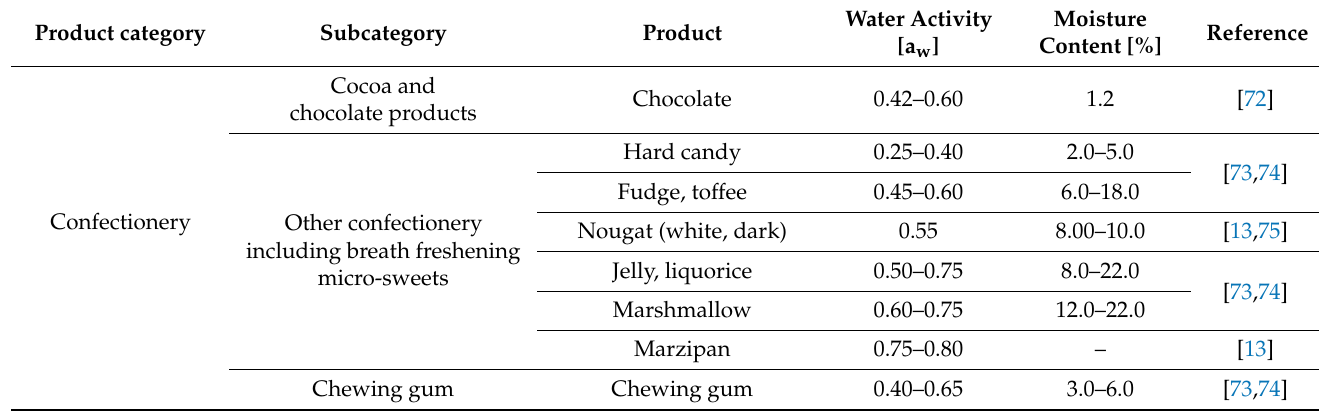
Table 2. Water activity and moisture content of confectionery products, breakfast cereals, snacks, and bakery